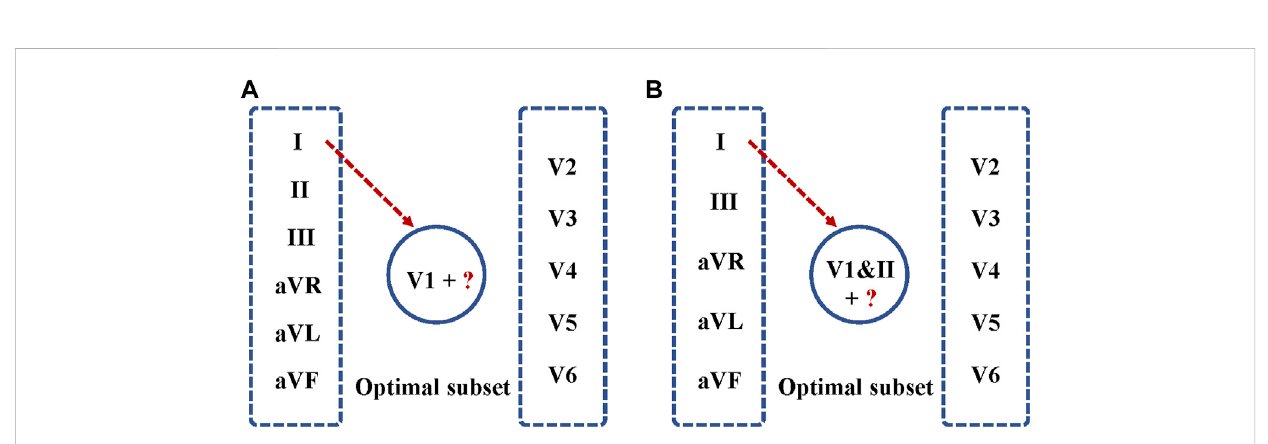
FIGURE 5 OptimalECGleadsubsetselectionforAFdetection. (A) LeadV1wastakenasthebaseelement,andotherleadswereconsideredascandidates.Each time, a single lead was added to the seed set for training, validation of the model, and testing. (B) Leads V1&II were selected as the base element, and the other 10 leads were considered as candidates for repeat searching.